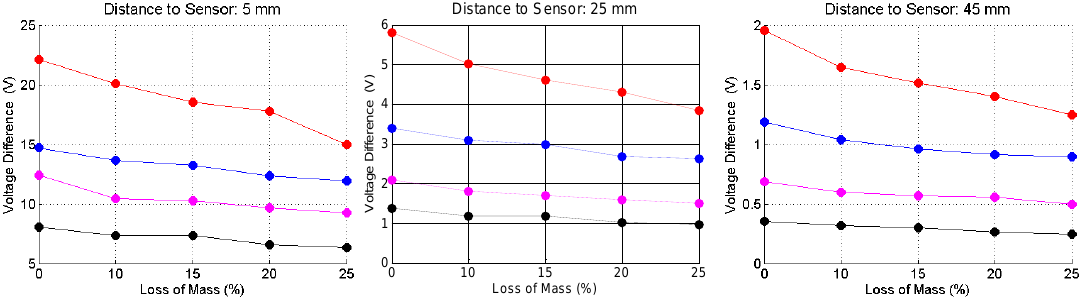
Figure 14. Voltage difference, as a function of the bar gauge, loss of mass and reference distance. Red curves—20 mm bar gauge; Blue curves—16.0 mm bar gauge; magenta curves—12.5 mm bar gauge; and black curves—10.0 mm bar gauge.